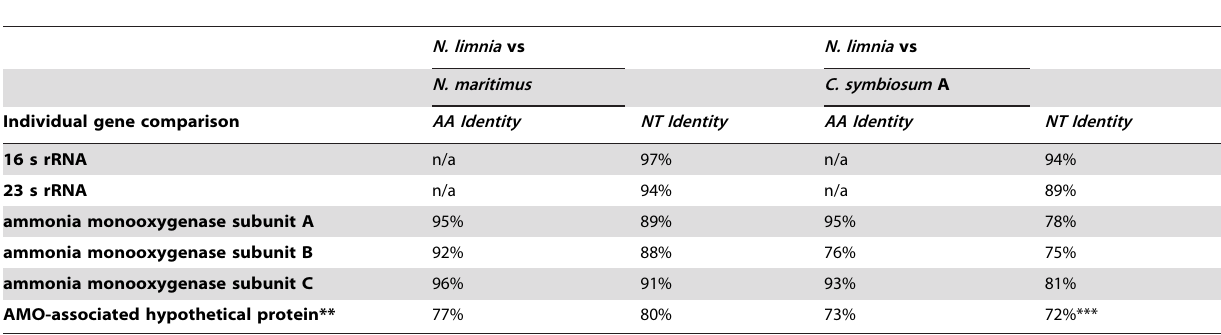
Table 5. Nucleotide (NT) and amino acid (AA) identities for key individual genes in N. limnia , N. maritimus , and C. symbiosum